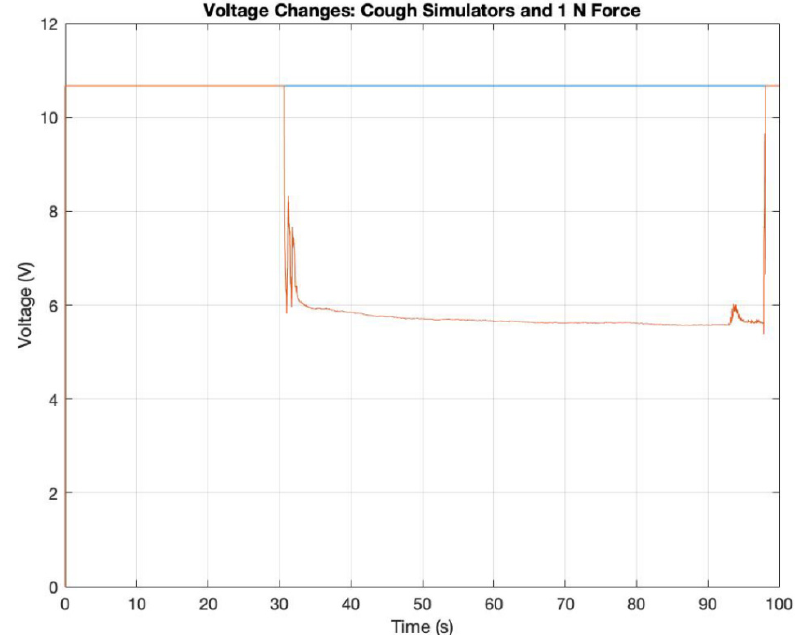
Figure 4. Force analysis of simulated coughs. A time-dependent graph of voltage that was captured using MATLAB during the force measuring experiment as all three simulated coughs, a human breath, and a human cough, were applied to the force-sensing resistor in the first 25 s with no voltage change and a contrast 1 N standard weight applied at 30 s.